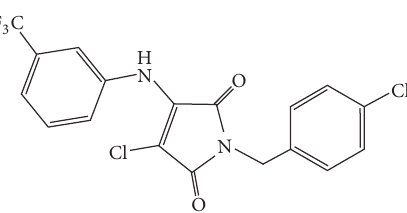
Figure 1: 1-(4-Cl-benzyl)-3-Cl-4-(CF 3 -fenylamino)-1 X -pyrrol-2,5- dione (MI-1): structural